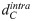
Protein-ligand interaction.A) Epibatidine and key residues (in licorice) in the binding pocket, in the homology model. The primary and complementary subunits are shown in blue and yellow cartoon representation, respectively. Epibatidine is in green. Chlorine (purple) and nitrogen (blue) atoms on epibatidine in ball representation. B) Representative snapshot along the Free3 trajectory with epibatidine in axial position, with the chlorine atom down; C) in equatorial position; D) epibaditine and key residues in the complementary subunit. E) distribution of dCintra. Data collected from the five subunits. The vertical dashed blue line represents the value in the starting homology modeled configuration. Black bars: unrestrained; red bars: restrained; green bars: free simulations (data averaged over the four free trajectories).